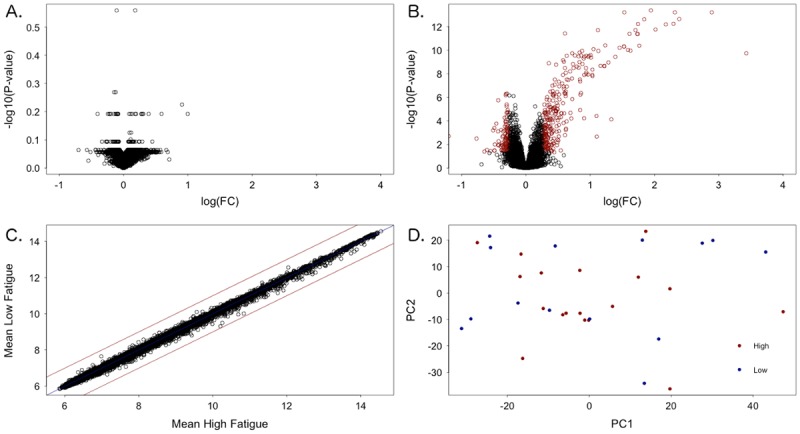
Differential gene expression analysis.(A) Volcano plot of high fatigue against low fatigue. No significant differentially expressed genes (DEGs) were detected. (B) Volcano plot of patients against healthy controls. Red points indicate DEGs with a fold change >1.2 and p-value <0.05. (C) The mean expression values for each gene for the high and low fatigue groups. (D) Plot of the first two principal components of the expression dataset coloured by high and low fatigue groups.